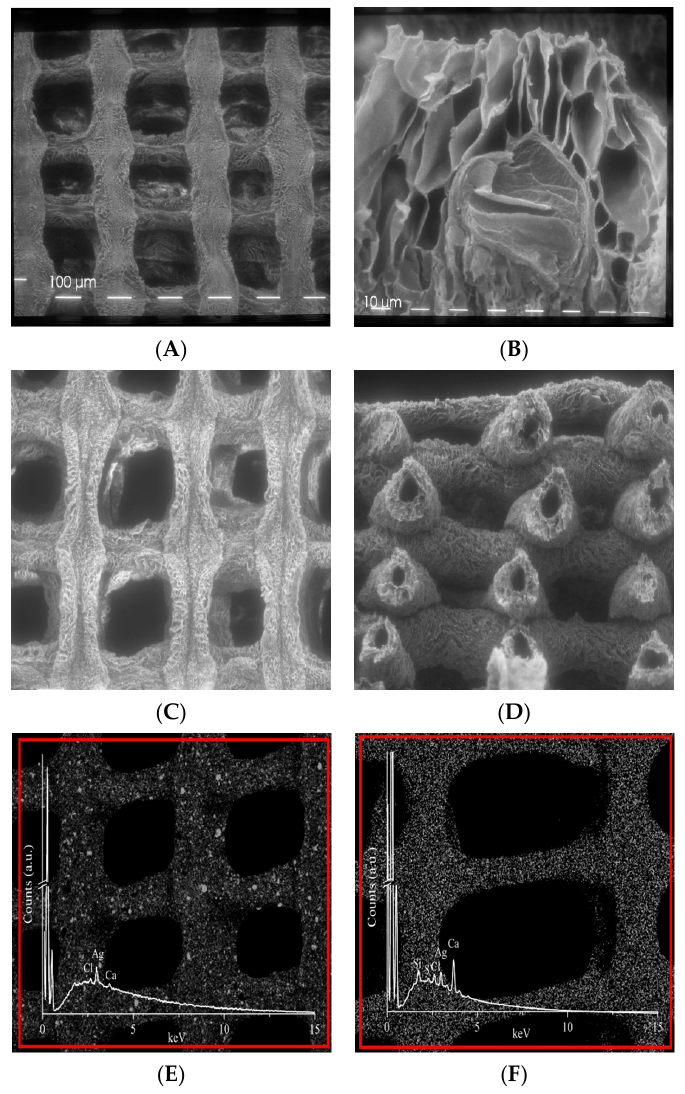
Figure 3. Scanning electron microscope images at different magnification of: ( A ) ALG 5% ( w/v ) scaffold (80×); ( B ) ALG 5% ( w/v ) scaffold (360×); ( C ) ALG/CNC (5% and 3% w/v ) scaffold (80×); ( D ) ALG/CNC (5% and 3% w/v) scaffold cross section (80×). Energy-dispersive X-ray spectroscopy (EDS) map distribution and EDS spectrum of Ag in: ( E ) ALG 5% ( w/v ) scaffold (80X); ( F ) ALG/CNC (5% and 3% w/v ) scaffold (80×). Table 1. Determination of antimicrobial activity of 3D-printed developed sca ff olds.